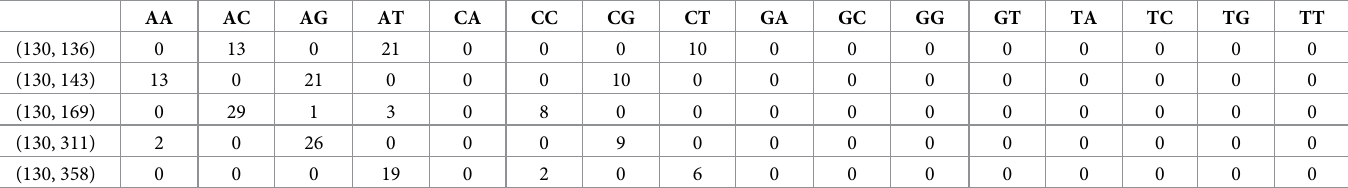
Table 1. Pairwise table